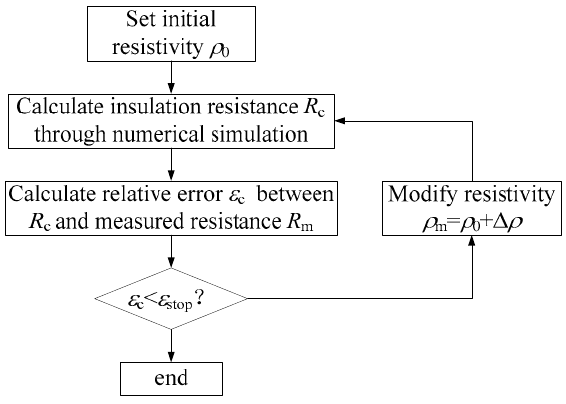
Figure 8. Basic idea of this iterative calculation.